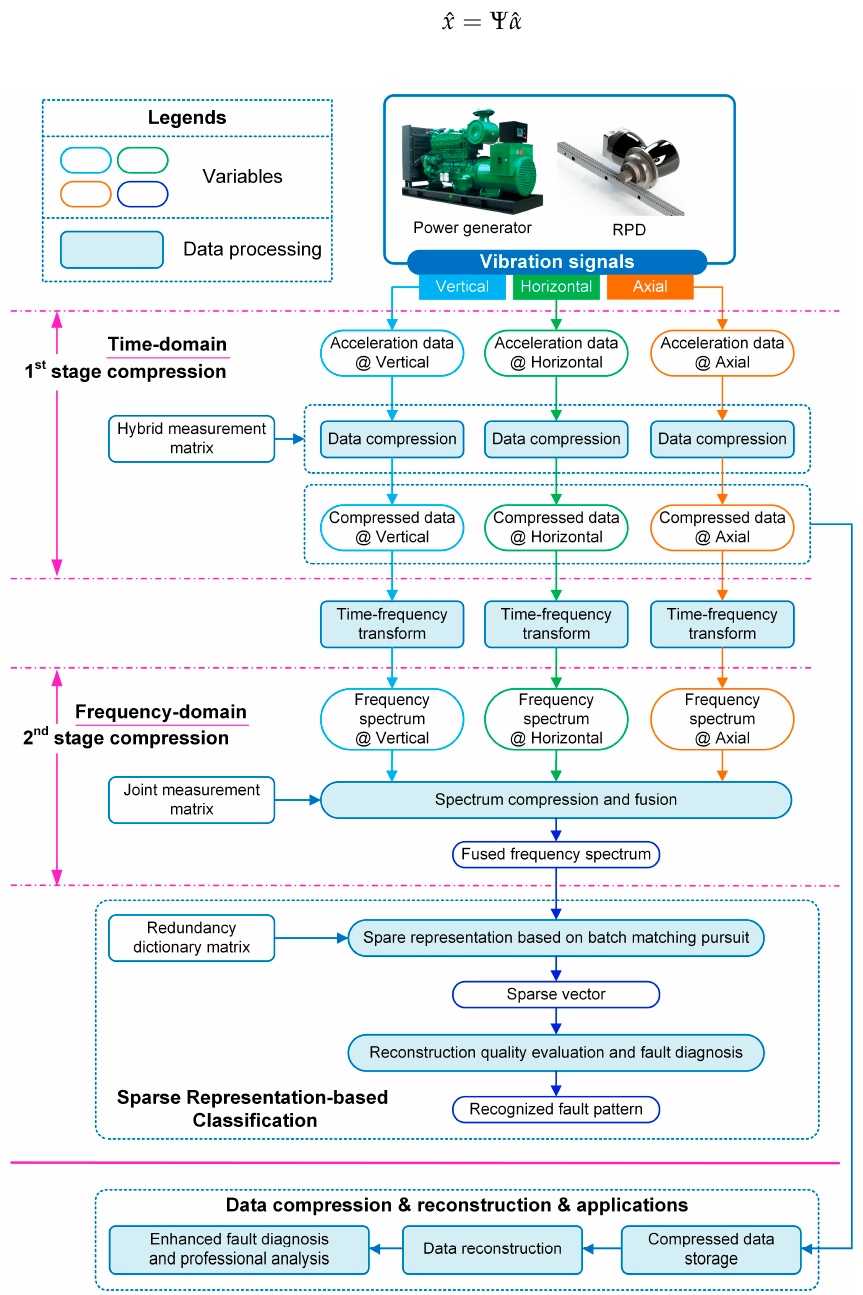
Figure 1. Framework of the proposed method.